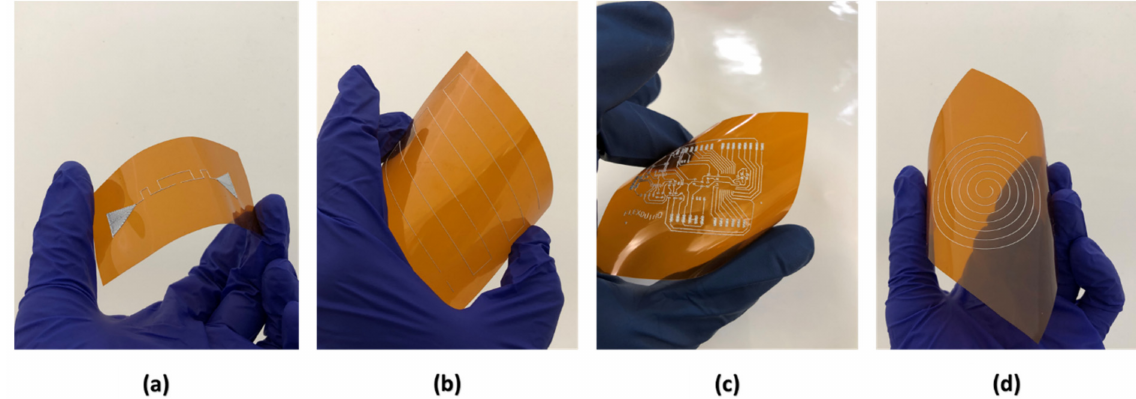
Figure 1. ( a ) RFID circuit ( b ) serpentine circuit ( c ) microcontroller circuit, and ( d ) induction coil printed using the magneto hydrodynamic metal jetting process.